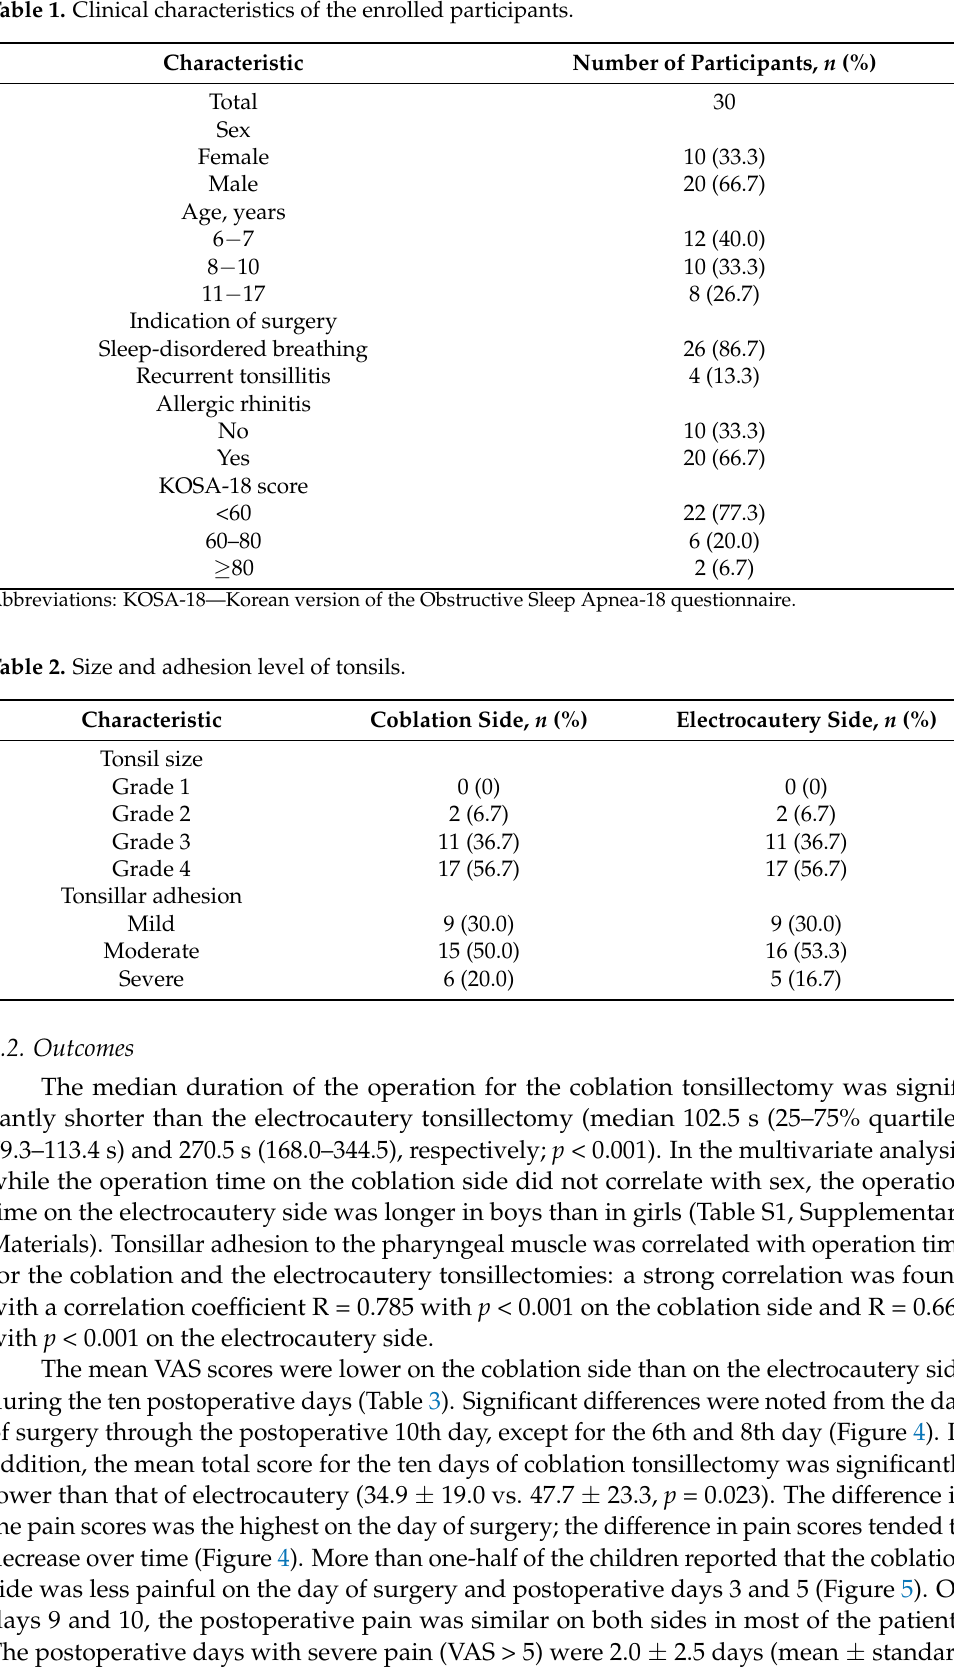
Table 1. Clinical characteristics of the enrolled participants.